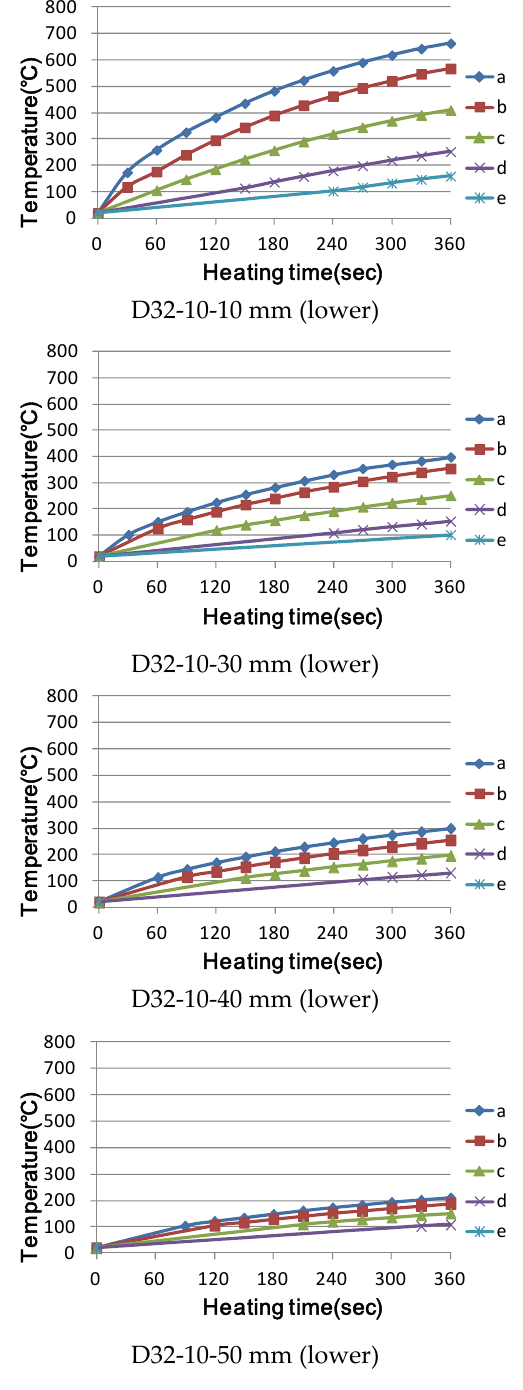
Figure 13. Temperature characteristics of crossed rebar (5 KW). (2) Frequency—5 kW output (side heating) In the case of conductive resistors, it is important to select a heating position because the heat transfer rate shows a sharp difference depending on the position and distance of the reinforcing bar applied to the heating coil as shown in Figure 14. In this experiment, it was not an intersection of the reinforcing bars. Reinforcing bars were placed in the center of the well-shaped reinforcing bars, and the temperature rise and temperature distribu- tion characteristics based on the diameter and distance of the reinforcing bars used were examined. Figure 15 shows the temperature characteristics.